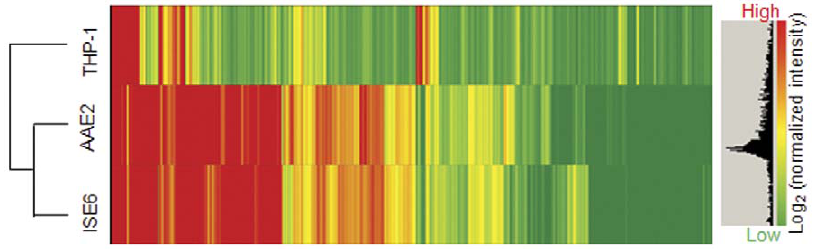
Figure 1. Microarray data of gene expression profiles from E.chaffeensis- infected human and tick cell lines. Heat map with gene expression in THP-1, AAE2 and ISE6 cells, coloring: red, up-regulated; yellow, normal; green, down-regulated.